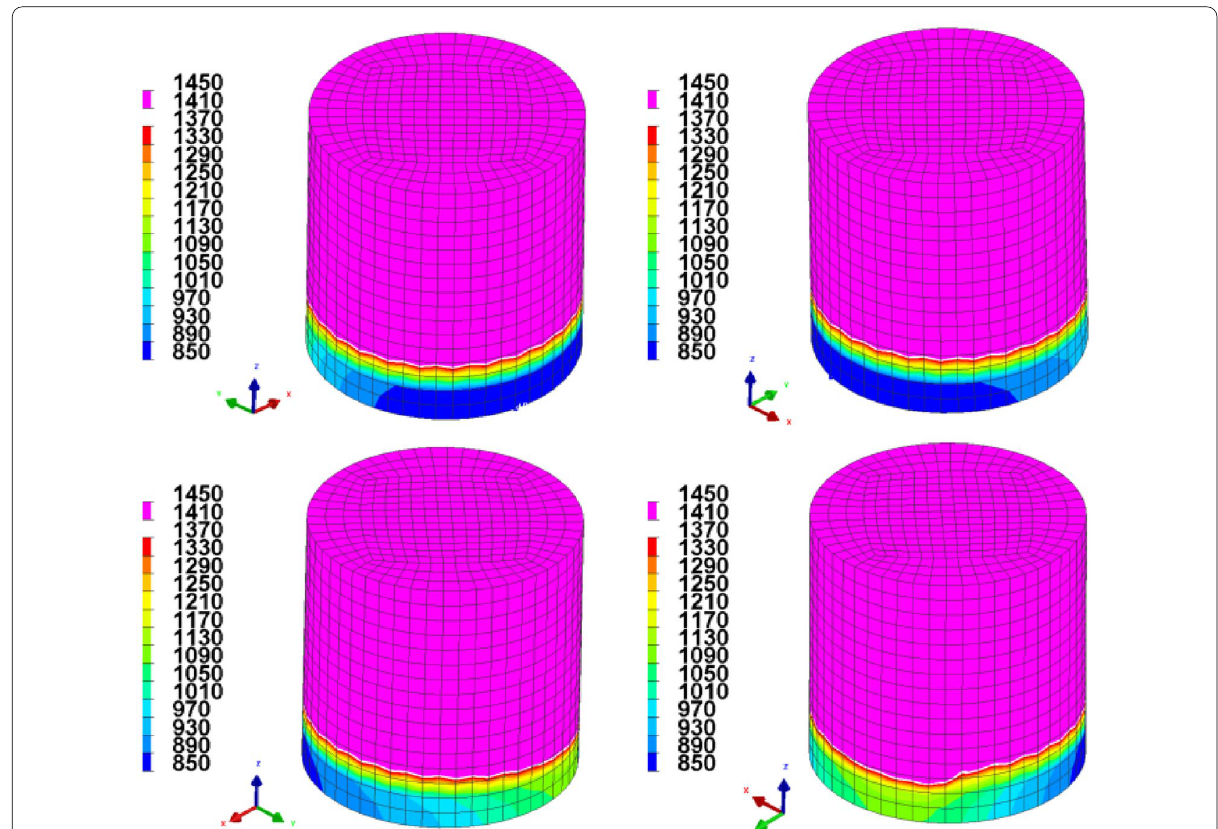
Figure 10 Temperature field distribution cloud map under the welding condition of